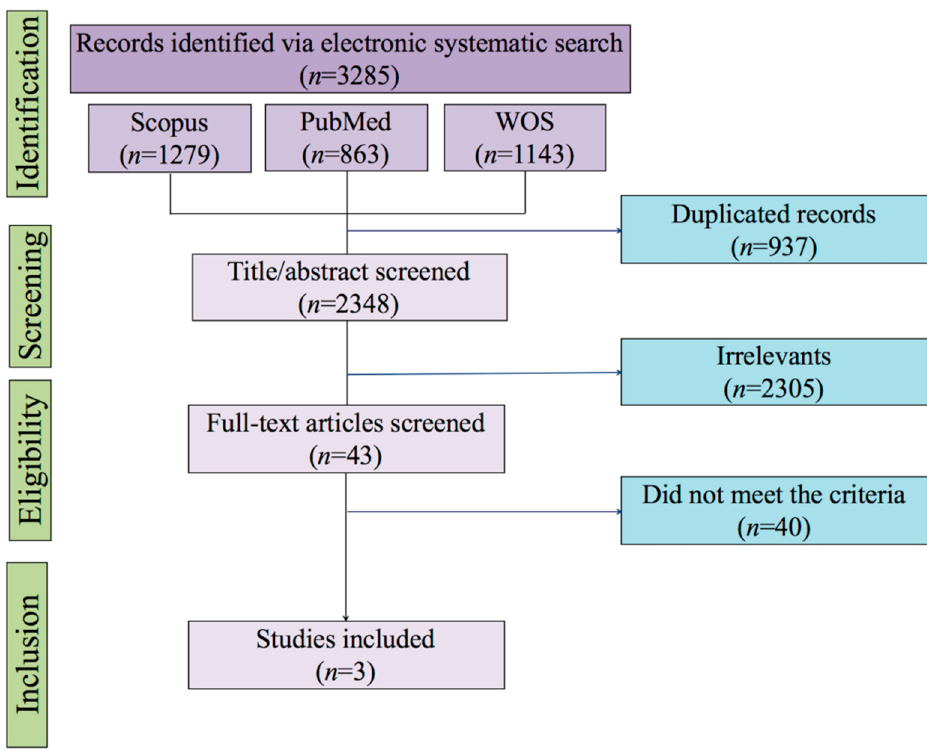
Figure 1. Flow diagram for study selection. Notes . WOS, web of science .